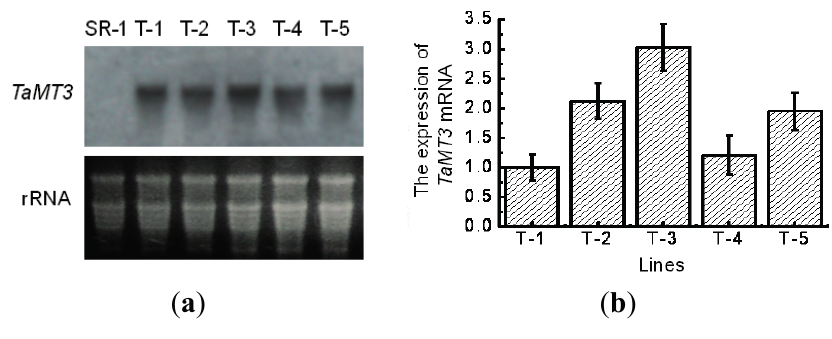
Figure 3. The expression analysis of TaMT3 gene in transgenic tobacco by northern blot and reverse transcription quantitative polymerase chain reaction (RT-qPCR) ( a ) northern blot analysis; and ( b ) RT-qPCR analysis using specific primers. SR-1, non-transformant; T-1 to T-5, transgenic